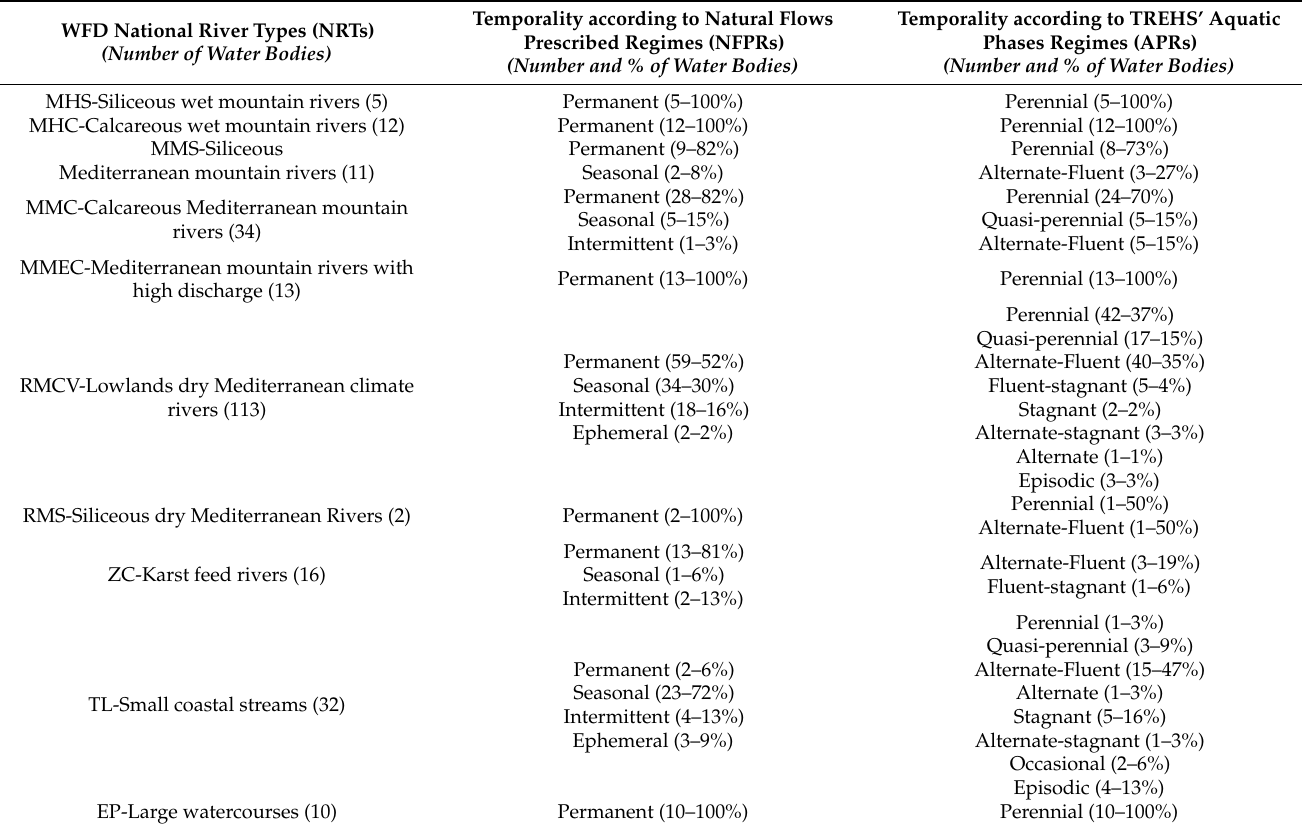
Table 1. Number and percentage of river water bodies classified according to flow regime temporality for each national river type (NRT) set in the Catalan RBD (officially used according to the water framework directive (WFD)). Two different methods were compared in order to classify temporality: (i) natural flows prescribed regimes (NFPRs) calculated by using a rainfall-runoff model; and (ii) aquatic phases regimes (APRs) calculated by using TREHS software (from the TRivers LIFE +